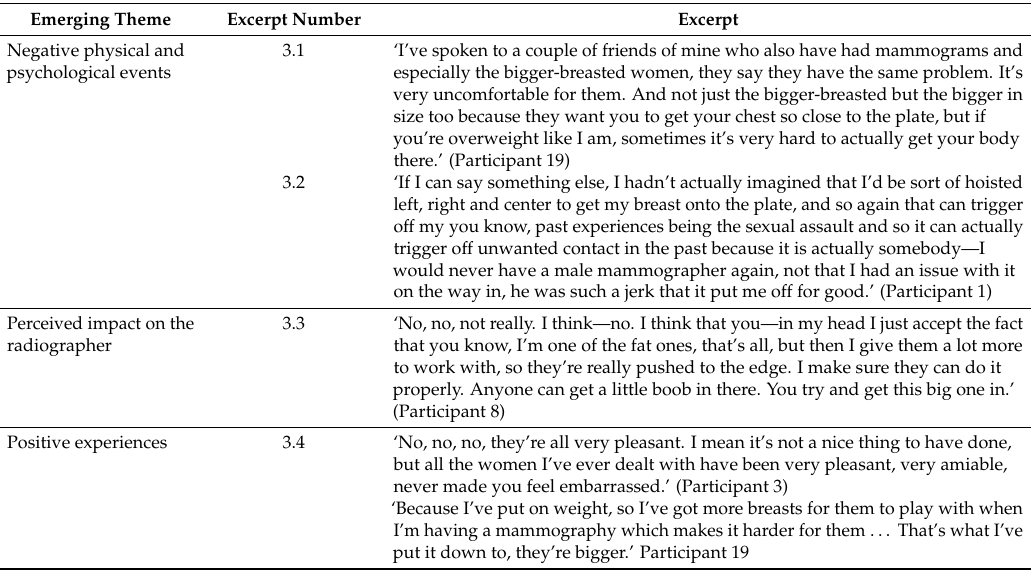
Table 5. Negative experiences for obese women during screening act as a deterrent to future